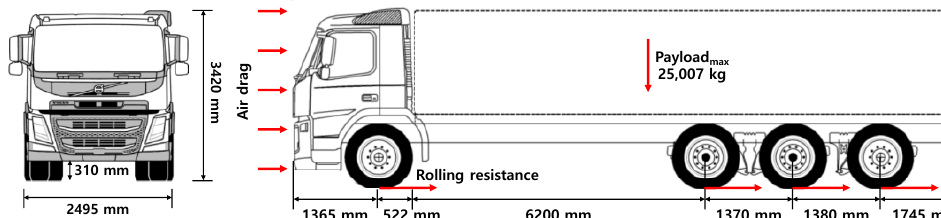
Figure 1. Image of the AVL Cruise heavy-duty vehicle model.